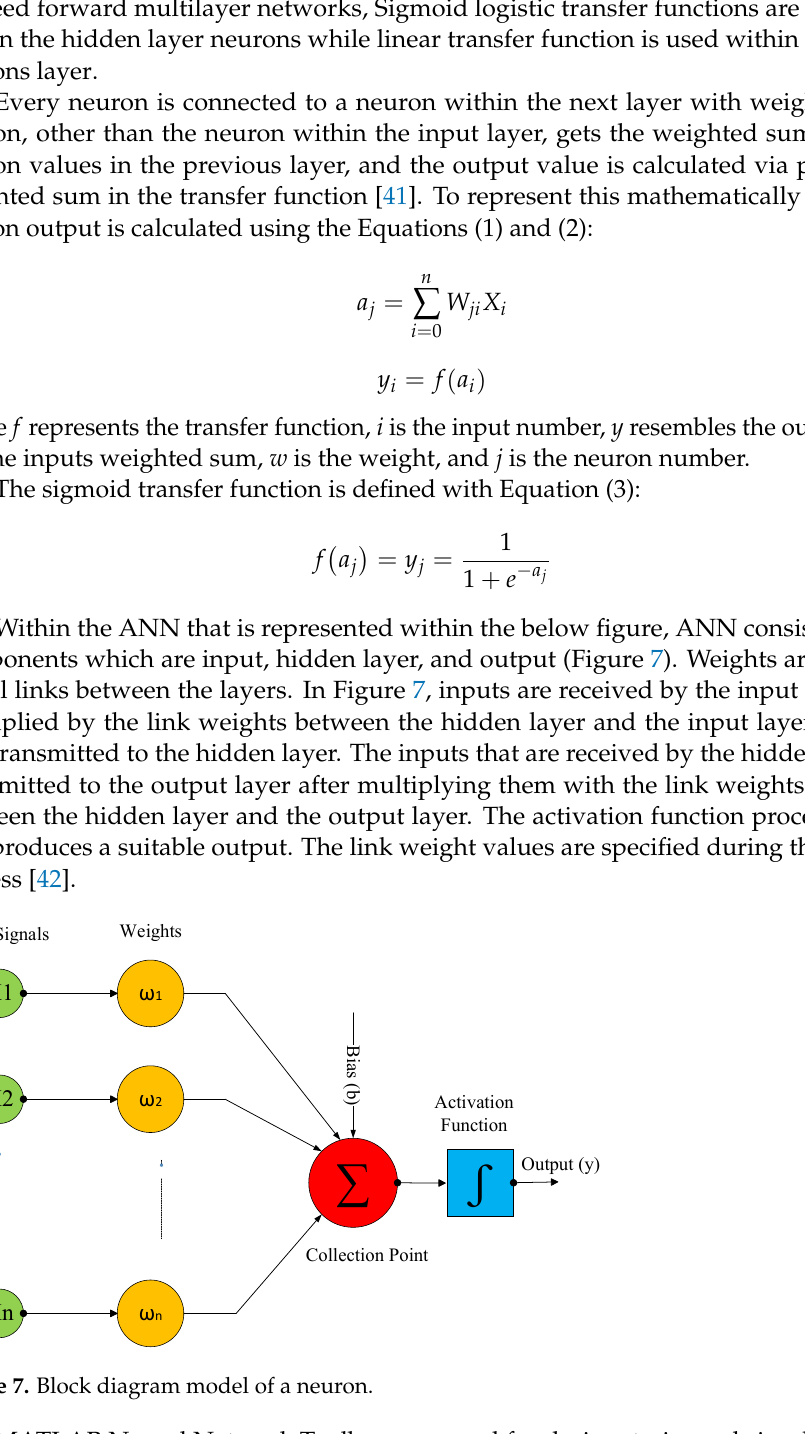
Figure 8. Structure of ANN model used in this study for Gokceada Island. The components of an ANN model are as follows: inputs, transfer function, layers, training algorithm and number of neurons. All those components are variable, so could be changed, but any changes would result in the creation of a new ANN model which would also yield completely different results. In this study, the ANN method used the Levenberg − Marquardt algorithm as the training algorithm. 3.2. Particle Swarm Optimization (PSO) The PSO algorithm was written by Kennedy and Eberhart in 1995. PSO is a swarm- based stochastic and intelligent algorithm that successfully solves optimization problems in all kinds of fields [43,44]. In this method, each possible solution known as a swarm represents population par- ticles. In this approach, the particle position changes continuously in a multidirectional search region until it reaches the optimal response and/or computational constraints. The speed of approaching the solution is a situation that develops randomly, and most of the